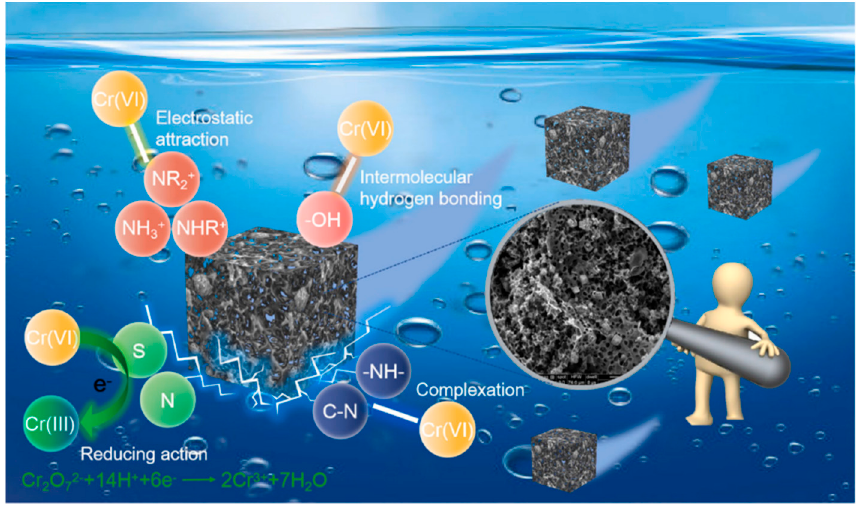
Figure 5. Adsorption mechanism of Cr (VI) by L-HPC. Reprinted with permission from Ref. [51]. Copyright 2022 Elsevier.